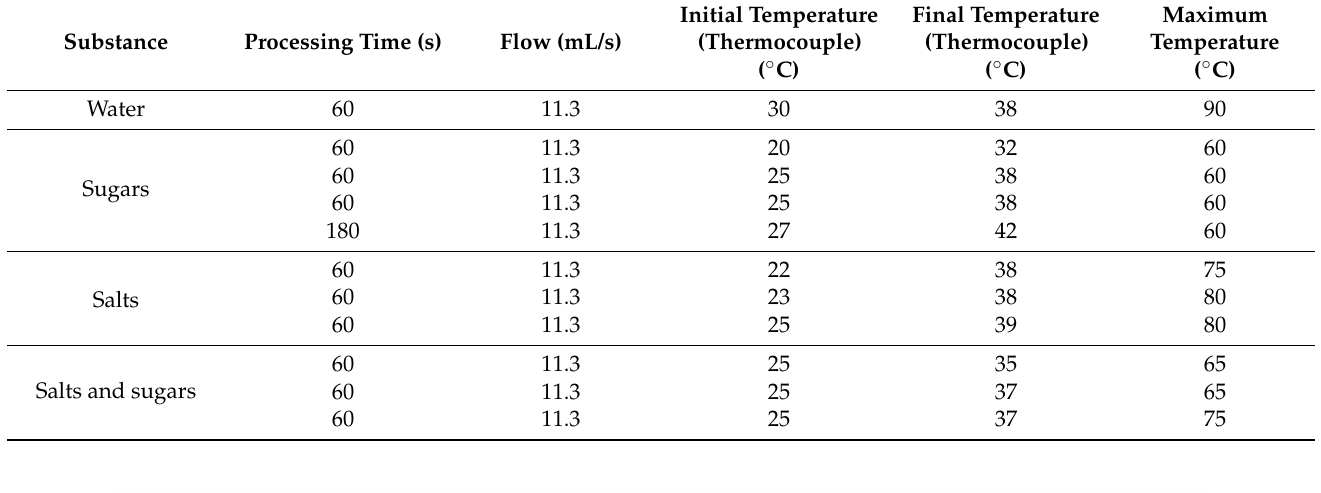
Table 1. Operational conditions of microwave processes.